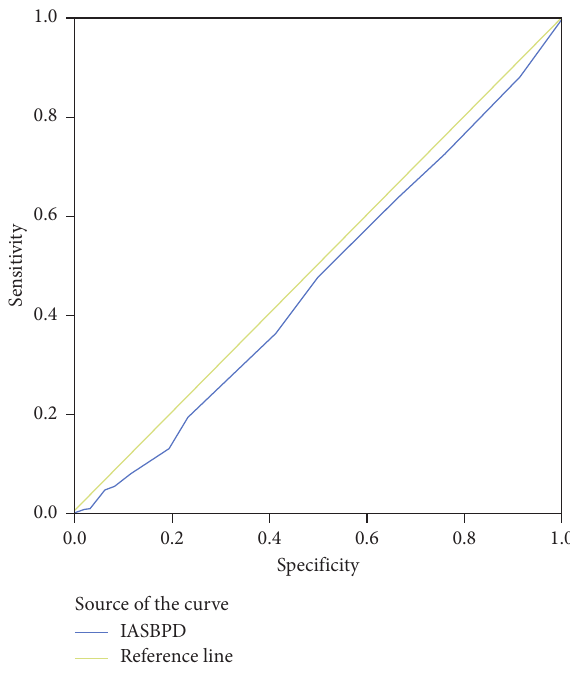
Figure 2: Evaluation of sensitivity and specificity of interarm systolic blood pressure difference (IASBPD) in the diagnosis of coronary artery disease based on ROC